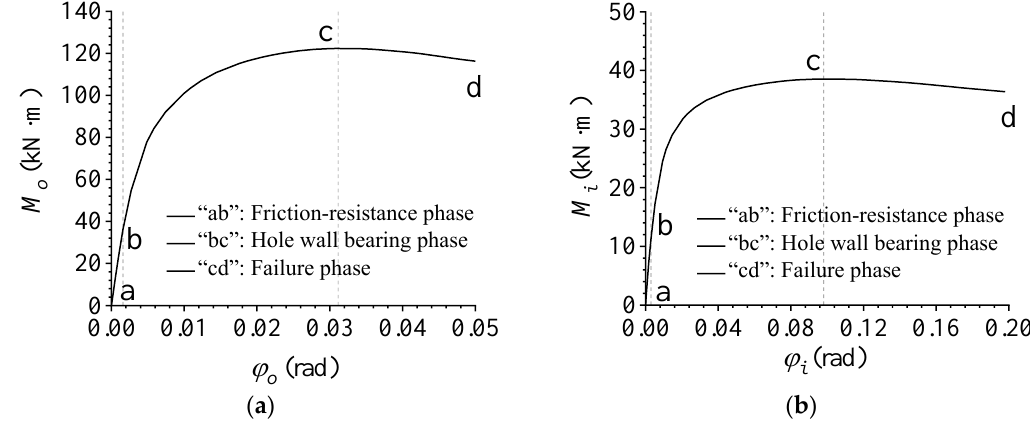
Figure 12. M–φ curves. ( a ) Out-of-plane M–φ curve; ( b ) in-plane M–φ curve. Figure 12. M– ϕ curves. ( a ) Out-of-plane M– ϕ curve; ( b ) in-plane M– ϕ